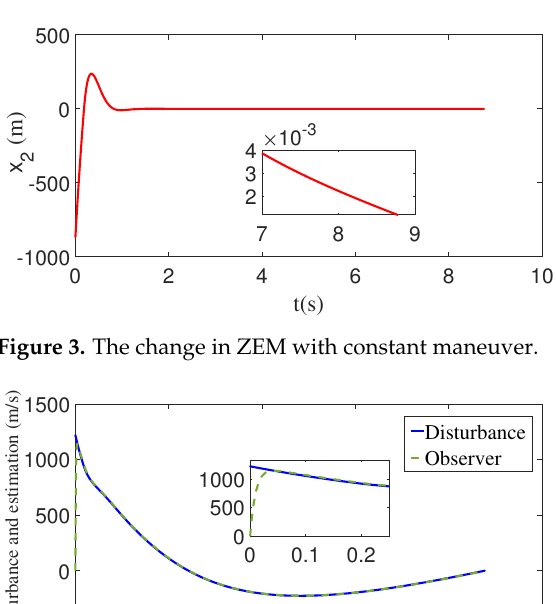
Figure 2. The change of the integral of ZEM with constant maneuver.